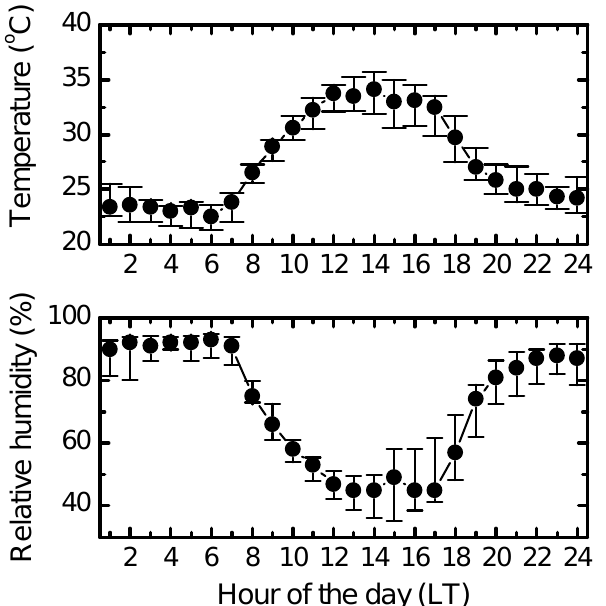
Figure 3. Diurnal variation of meteorological parameters during the SAMBBA campaign. The top plot indicates temperature and the bottom plot relative humidity. Circles represent median values, and bars represent 10 and 90 percentiles. Data from the National Insti- tute of Meteorology.